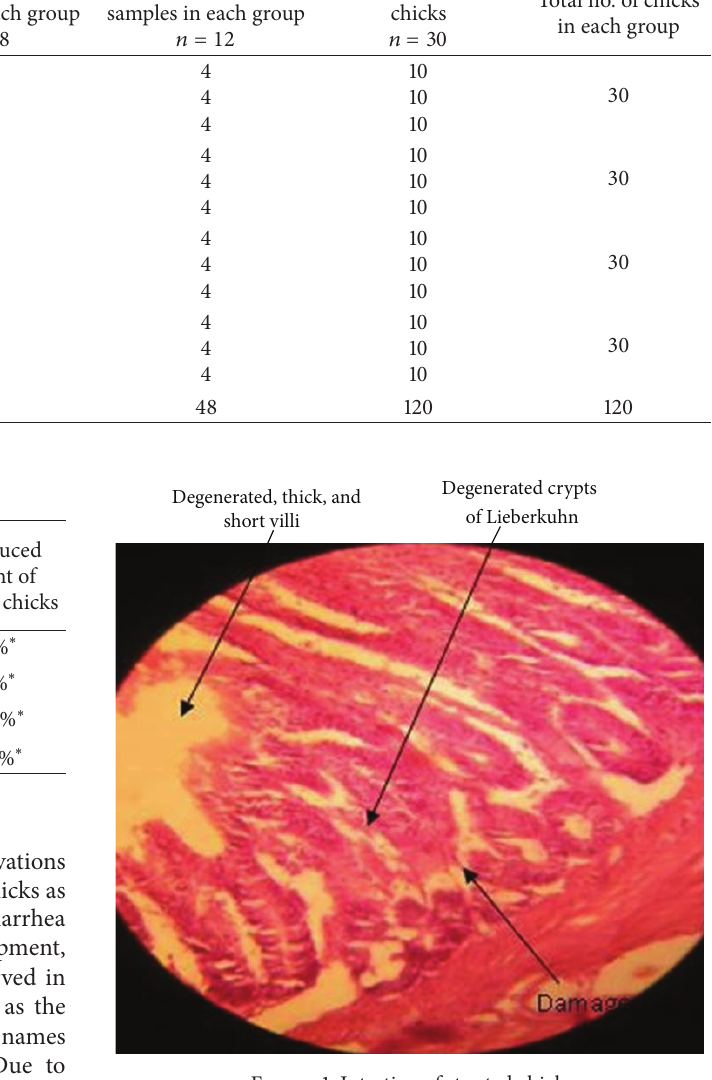
Figure 1: Intestine of stunted